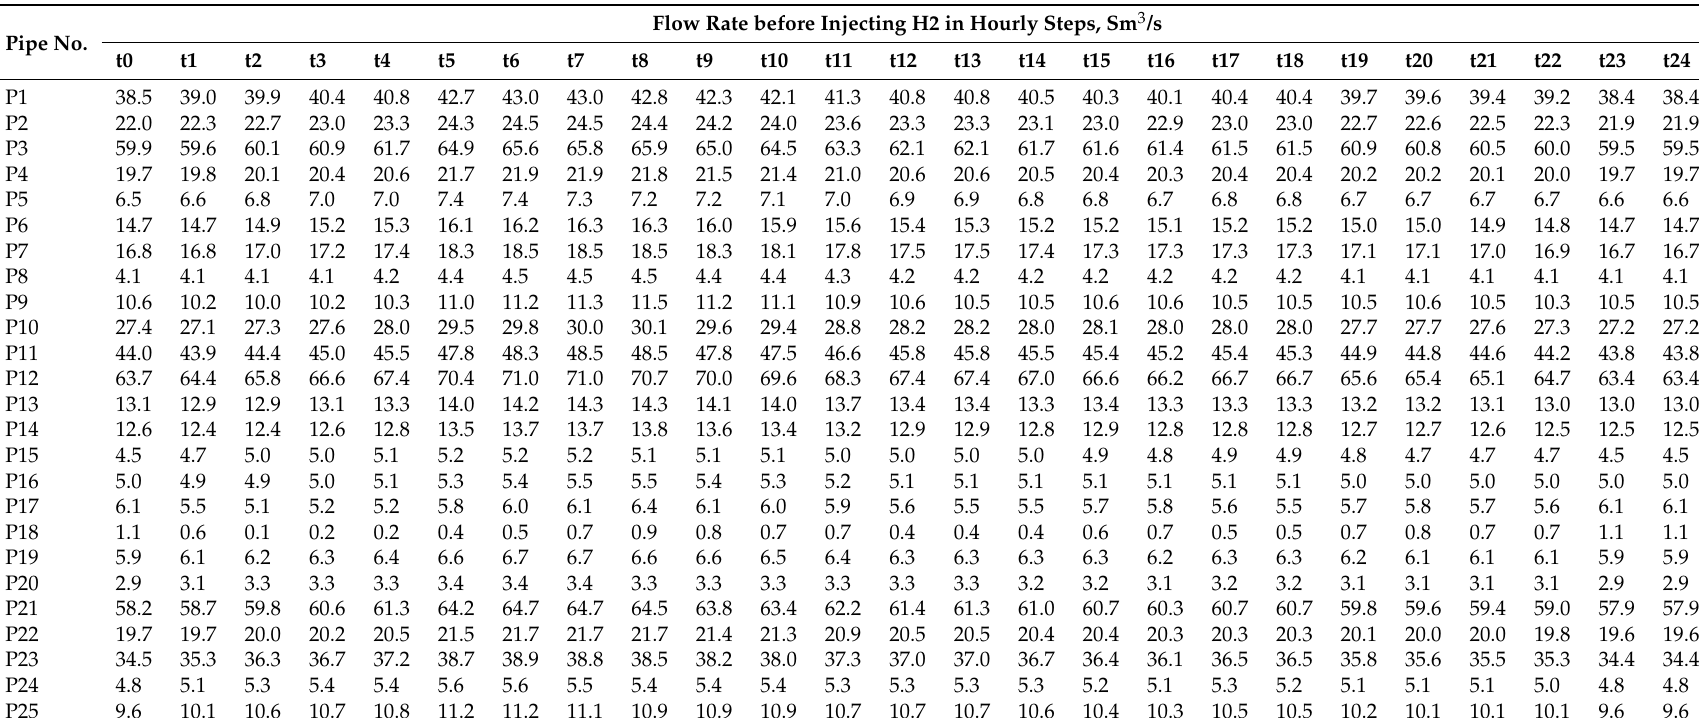
Table A3. Flow rate before injecting H2 in hourly